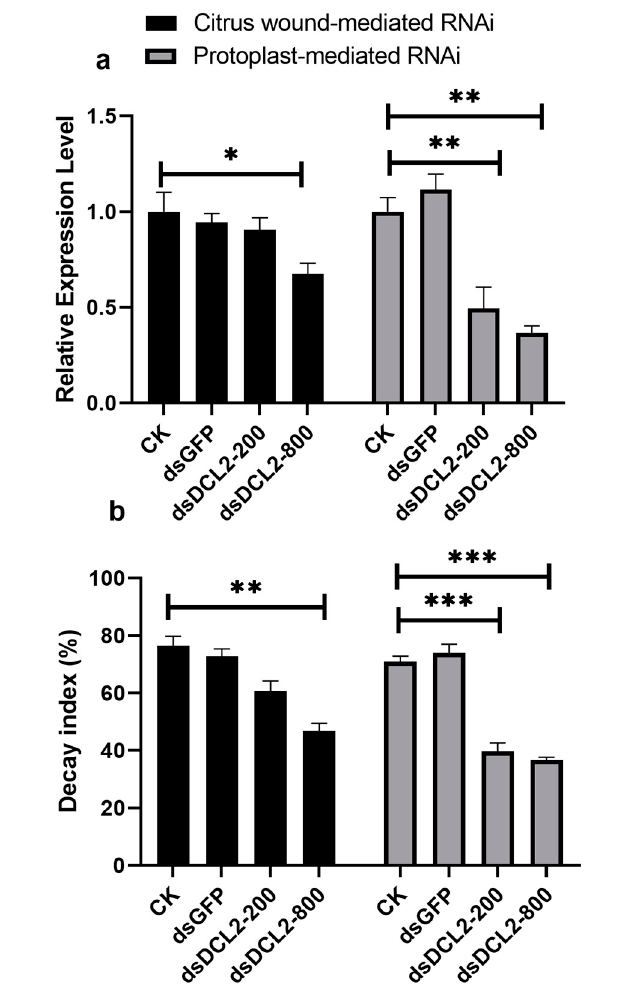
Figure 4. Effects of citrus wound-mediated RNAi and protoplast-mediated RNAi on the expression profile of the Pit-DCL2 gene ( a ) and the citrus decay index caused by wild-type P. italicum infection ( b ). dsDCL2-200 and 800 mean the concentration of the treated dsRNA is 200 ng and 800 ng, respectively. Each bar represents a mean ± standard error ( n = 3), and the asterisk indicates a significant difference (*, p < 0.5, **, p < 0.01, ***, p < 0.001).